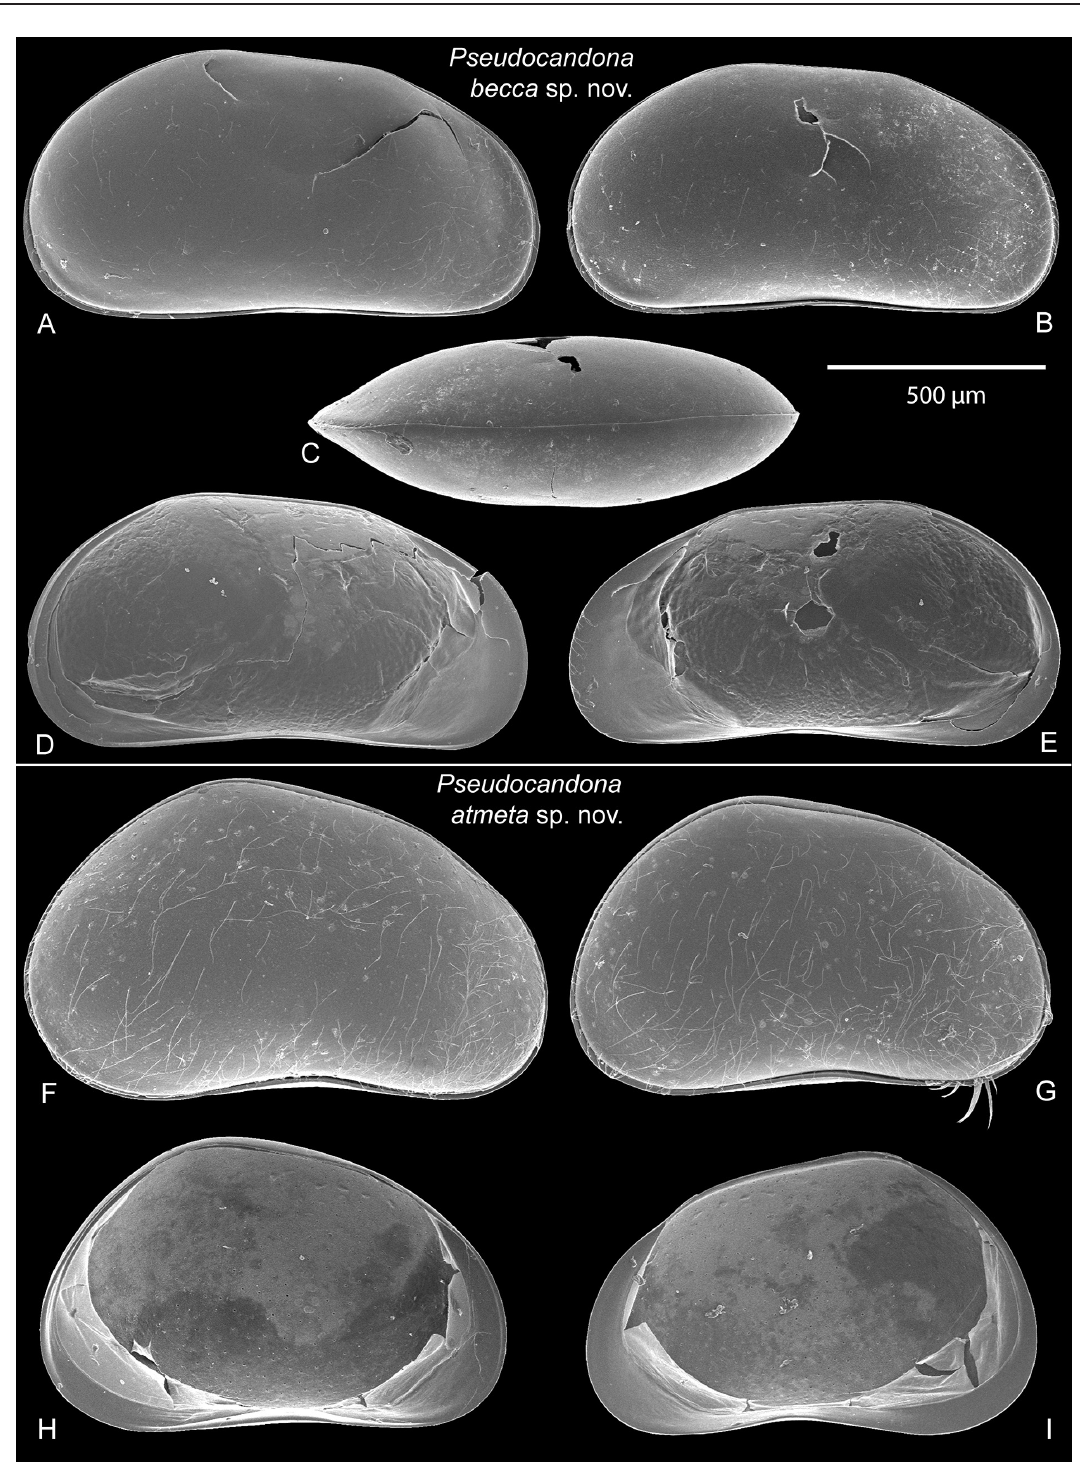
Fig. 2. A–E . Pseudocandona becca sp. nov. A . Right view of male carapace (LBM 1430006268). B . Right view of female carapace (LBM 1430006269). C . Dorsal view of female carapace, anterior to left (LBM 1430006269). D . Internal view of female left valve (LBM 1430006269). E . Internal view of female right valve (LBM 1430006269). F–I . Pseudocandona atmeta sp. nov. F . Right view of male carapace (LBM 1430006272). G . Right view of female carapace (LBM 1430006273). H . Internal view of female left valve (LBM 1430006274). I . Internal view of female right valve (LBM